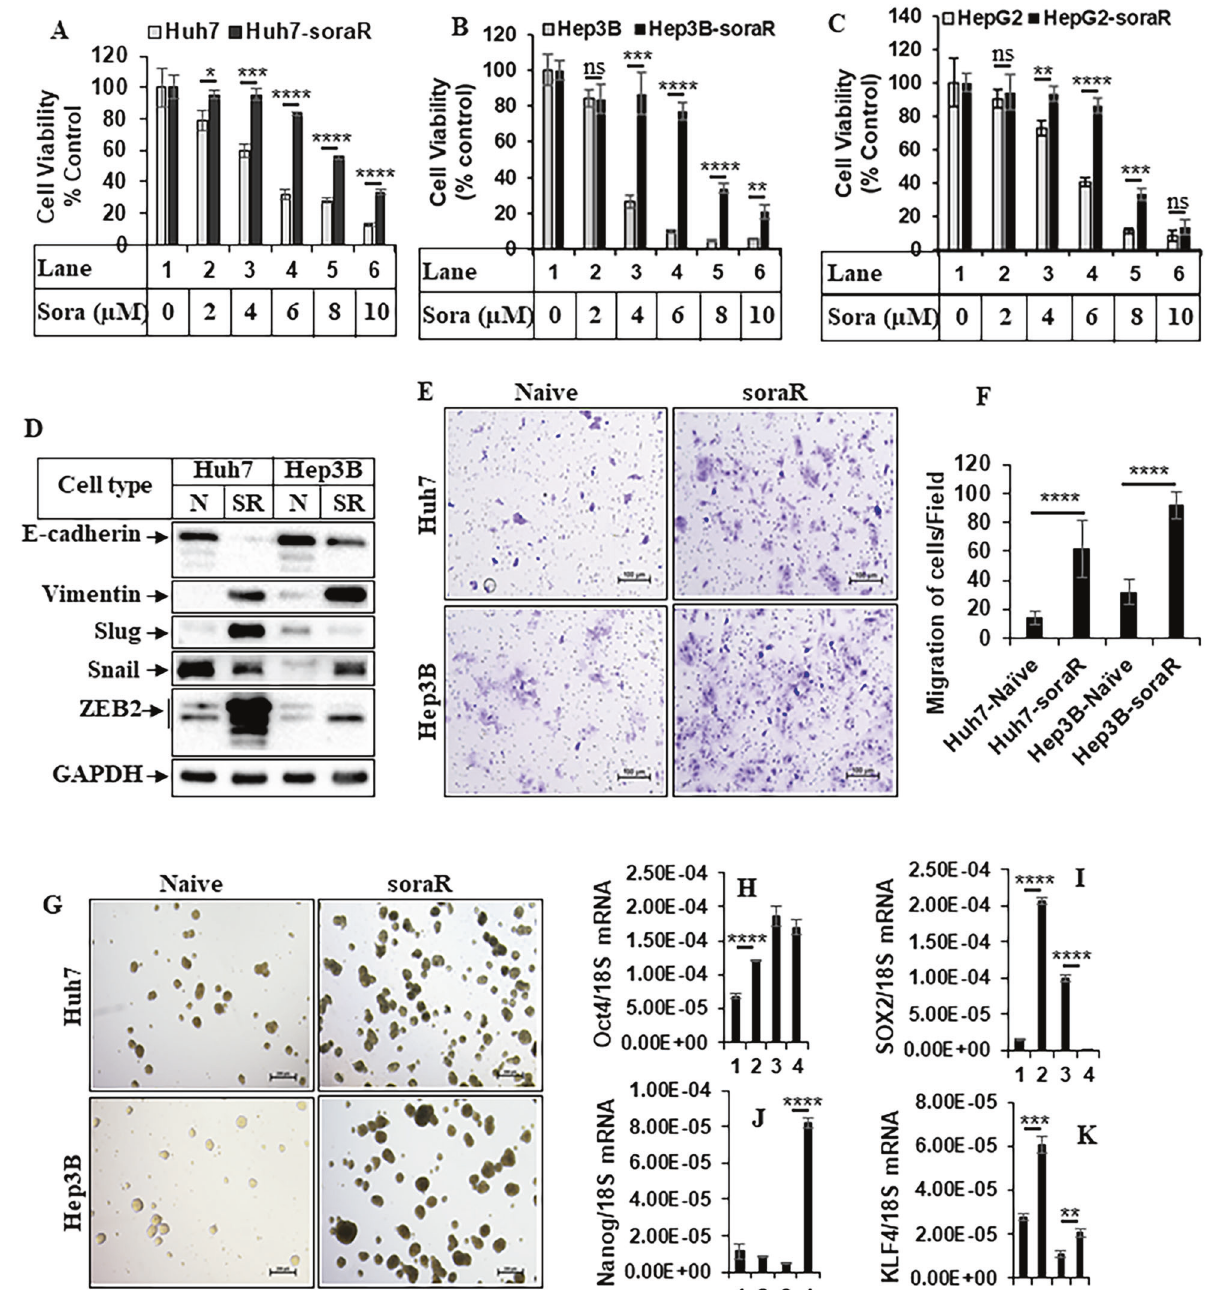
Fig. 1 Characterization of soraR HCC cells. A Huh7, B Hep3B, and C HepG2 naive and sorafenib-resistant (soraR) cells were treated with increasing concentrations of sorafenib and subjected to MTT assay after 72 h. The values were expressed as % control considering DMSO- treated samples as 100%. Each assay was performed in triplicate, and each experiment was repeated at least two times. The data represent the mean ± S.D of three independent assays. D Equal amounts of total protein from naive (N) and soraR (SR) HCC cells were analyzed by western blots with the indicated antibodies. E Naive and soraR cells plated in transwell plates were allowed to migrate for 48 h and images were captured using NIS-Elements imaging software in Nikon Eclipse Ti Microscope. Scale bar, 100 µm. For quantitation, cells were counted in four different fi elds and plotted as bar graphs ( F ). The data represent the mean ± S.D. of two independent experiments. G Naive and soraR cells were plated in ultra-low attachment plates to form spheres, and the spheres were photographed on day 7 using NIS-Elements imaging software in a Nikon Eclipse Ti microscope. Scale bar, 200 µm. H – K RNA extracted from naive and soraR spheres as described in G were analyzed by qPCR with the indicated genes. Lane 1: Huh7-N, Lane 2: Huh7-SR, Lane 3: Hep3B-N, Lane 4: Hep3B-SR. The data represent the mean ± S.D. of three independent qPCR reactions. Signi fi cant differences were determined by t test and indicated as: ns, p > 0.05; * p ≤ 0.05; ** p ≤ 0.01; *** p ≤ 0.001; **** p ≤ 0.0001.